Question: In one sentence, what is this figure communicating?
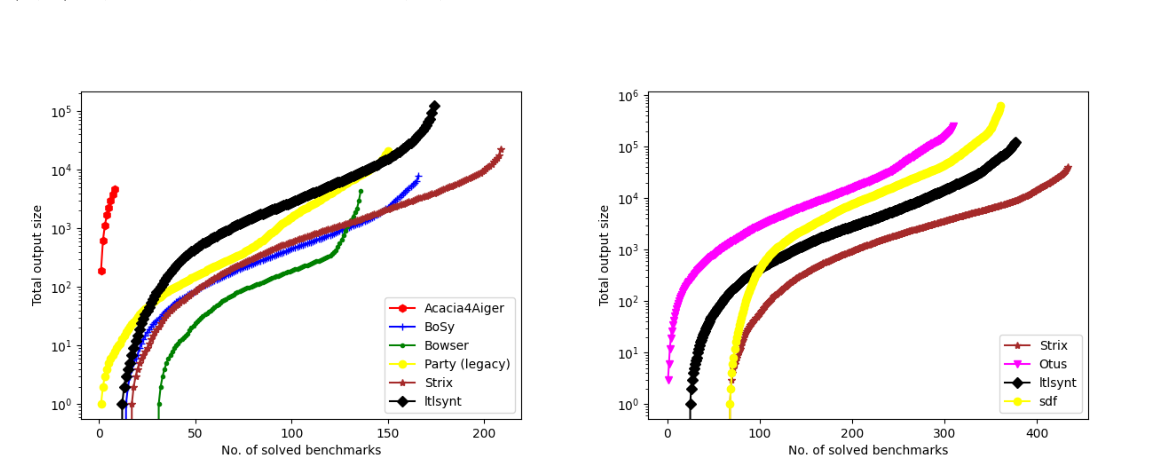
Answer: Cactus plots for the participants of the LTL synthesis track of SYNTCOMP 2018 (left) and 2021 (right) — this time, showing total output size instead of time (counting AND-gates only); Note that the y-axis is displayed using logarithmic scale